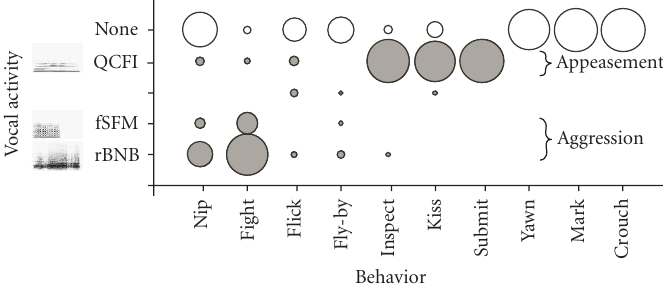
Figure 9: A bubble-plot (filled dark grey circles) showing the association of di ff erent sounds with di ff erent behavioral actions. The size of the bubble is proportional to the normalized (percentage of total events) frequency of occurrence of a call type. Per the Motivation-Structure hypothesis, which states that animals motivated by aggression produce relatively low-frequency, noisy, broadband calls (here illustrated by rBNB and fSFM calls) and those motivated by fear and/or appeasement produce tonal high frequency calls (here illustrated by QCFl calls). No calls were emitted during yawning, marking, and crouching. Fighting, which can be a complex and long-lasting behavior, produced the largest variety of call types. Unfilled circles are proportional to the percentage of the total number of events when a call did not accompany a particular behavior. Adapted from